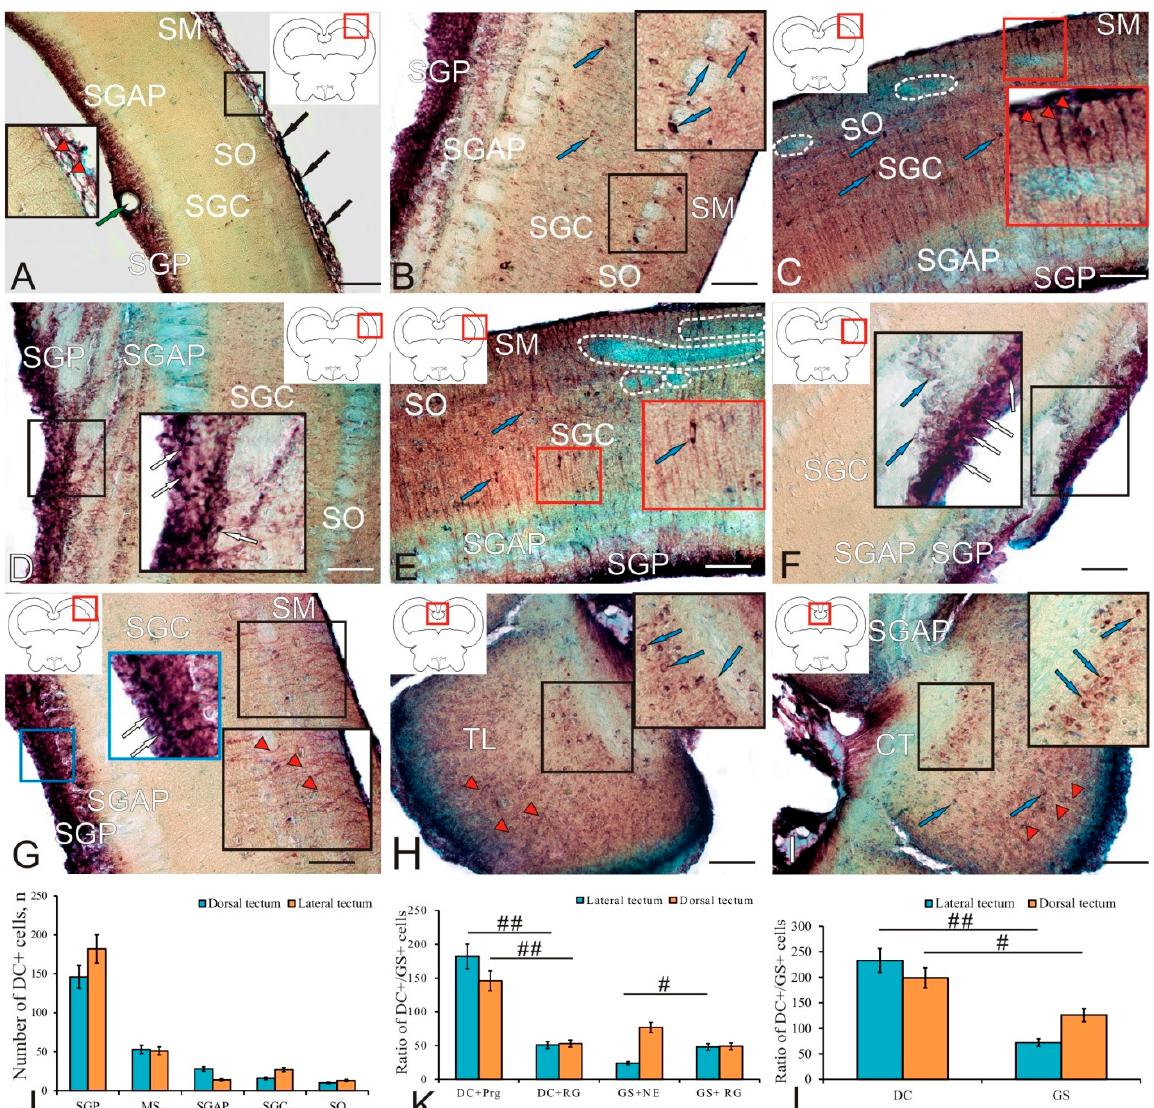
Figure 4. Doublecortin (DC) in the tectum opticum of trout, Oncorhynchus mykiss : ( A ) a general view of DC distribution in the dorsolateral tectum, intensely labeled cells (red arrowheads) and RG (inset) in the SM, a large vessel in the SGP (green arrow), and pia mater (black arrows); ( B ) DC+ cells (blue arrows) in the inner layers of the tectum (inset); ( C ) DC+ RG (red arrowheads) in SM (inset) and constitutive neurogenic niches (bounded by white dotted line) in the basal part of SM and/or SO; ( D ) patterns of distribution of DC+ cells (white arrows) in SGP (inset) and in the inner layers of the lateral tectum; ( E ) large constitutive niches in MS and SO (bounded by white dotted line) and single large bipolar DC+ cells (blue arrows) in SGC (inset) in the lateral tectum; ( F ) a dense layer of intensely labeled DC+ cells (white arrows) in SGP (inset) in the lateral tectum and migrating weakly labeled cells (blue arrows); ( G ) intensely labeled DC+ cells (white arrows) in SGP (blue inset) and DC+ RG (red arrowheads) in SM (black inset) in the dorsolateral tectum; ( H ) a heterogeneous population (inset) of DC+ cells (blue arrows) in the torus longitudinalis (TL) and RG fibers (red arrowheads); ( I ) intertoral commissures (CT) and a heterogeneous population of polygonal DC+ cells (inset) (other designations as in ( H )). Scale bars: ( A ) 200 µ m and ( B – I ) 100 µ m. ( J ) A comparative distribution of DC+ cells (M ± SD) in the dorsal and lateral tectum; ( K ) a comparative distribution of DC+ neuroblasts and DC+ RG in the tectum with significant intergroup differences in the number of cells in the lateral and dorsal tectum, ## ( p < 0.01) ( n = 5 in each group), GS+ NE and GS+ RG in the tectum with significant intergroup differences in the number of cells in lateral tectum, # ( p < 0.05) ( n = 5 in each group),